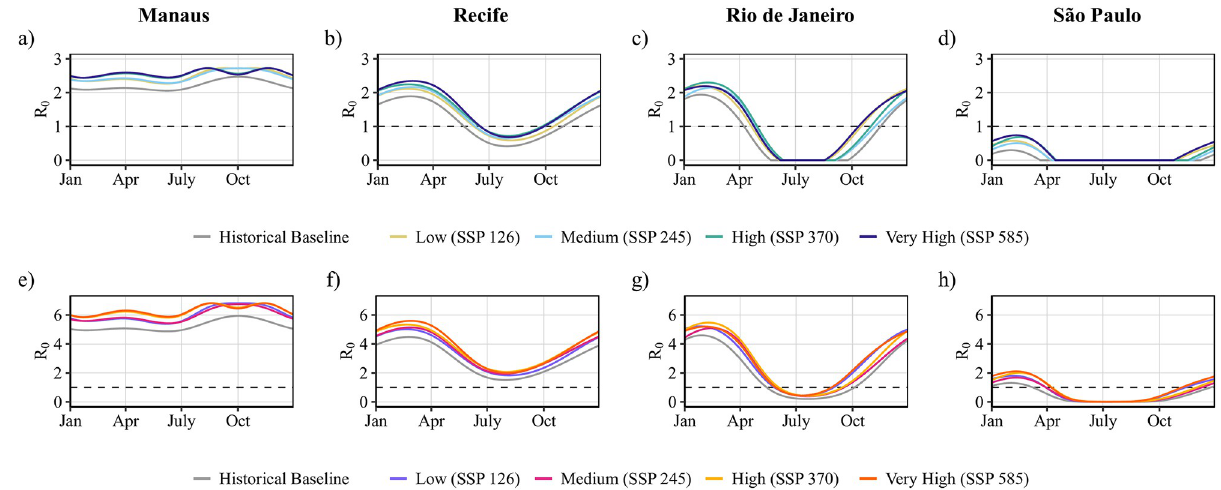
Fig 3. Projection of seasonal epidemic potential R climate change scenario.